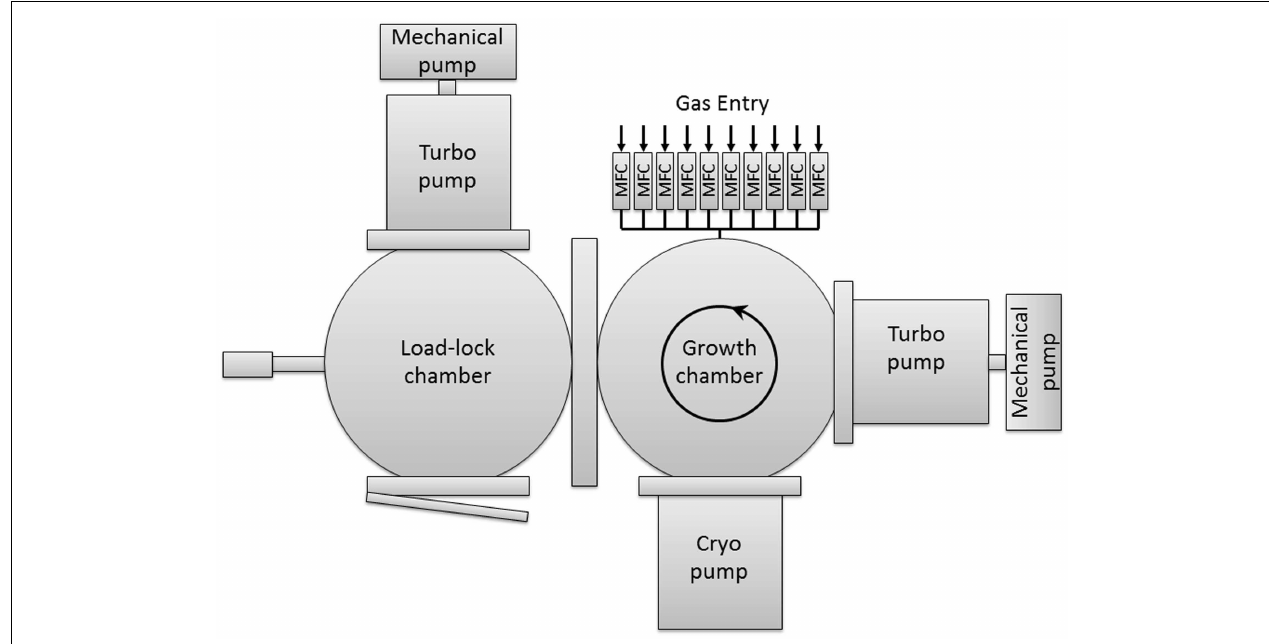
FIGURE 1 | Cold-wall UHV-CVD system with a substrate rotation . Samples are transferred through a load-lock chamber equipped with a turbo-molecular pump.The growth chamber is equipped with a turbo-molecular pump and a cryogenic pump. Side entry of the gases is controlled by mass flow